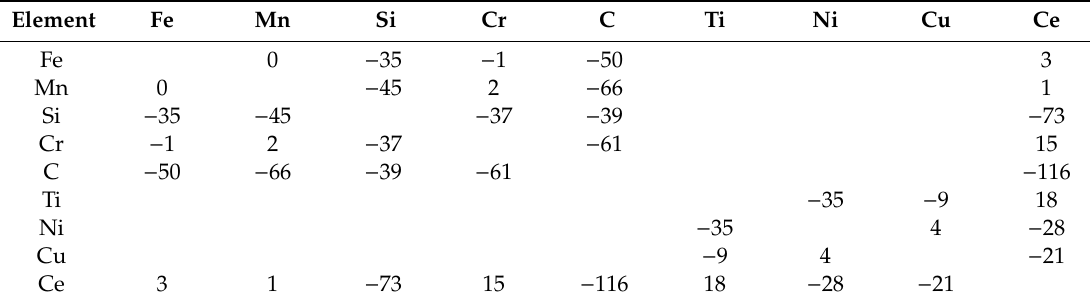
Table 1. ∆ H mix of the binary elements [20]. AB